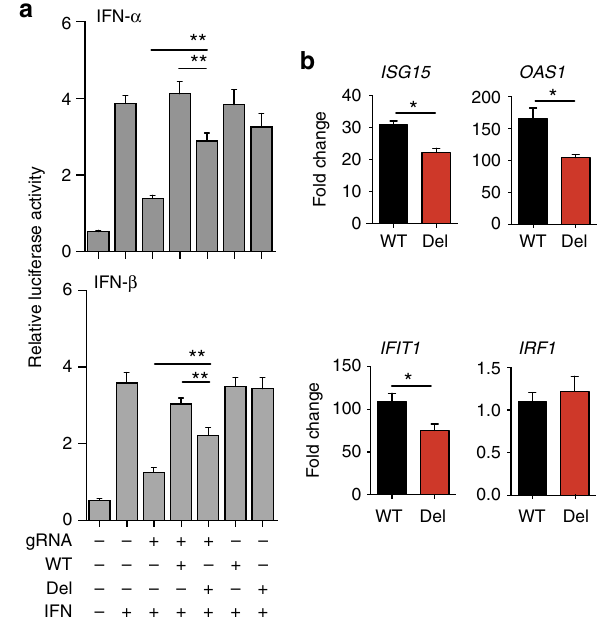
Fig. 4 TCC deletion in IFNAR1 impairs type I IFN signal transduction. Ifnar1 − / − MEFs were transfected with vectors expressing WT (black) or mutant (red) IFNAR1 together with IFNAR2 and ISRE-driven luciferase reporter plasmids. a Luciferase activity in WT or TCC-deleted IFNAR1 -